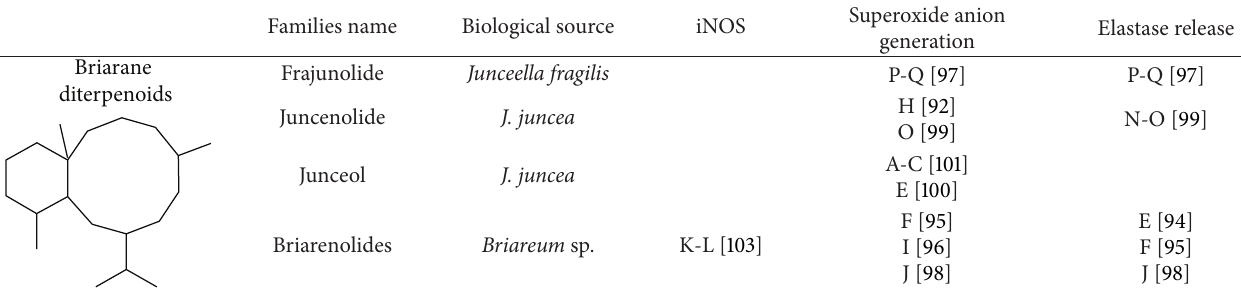
Table 2: Anti-inflammatory effect of briarane diterpenoids.